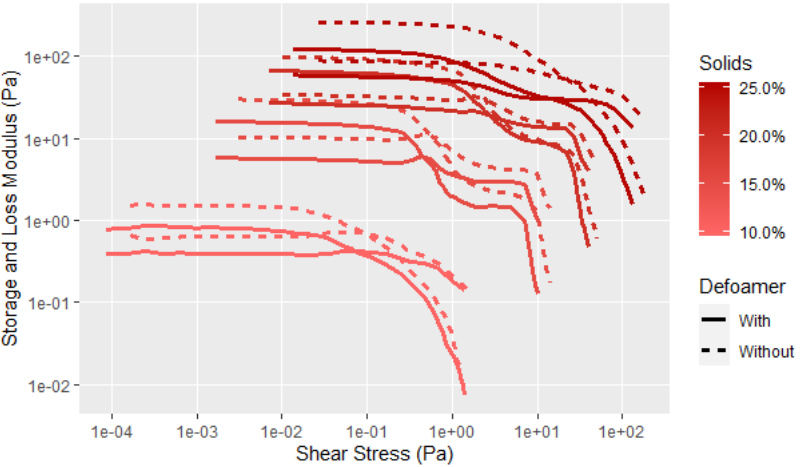
Figure 3. Comparison of the effect of a defoamer from low (10%) to high (25%) soy flour dispersions where the mixing time prior to rheological measurement was 15 min. The data at low shear stress, as in the lower solids, is more variable at the lower measurement limit.